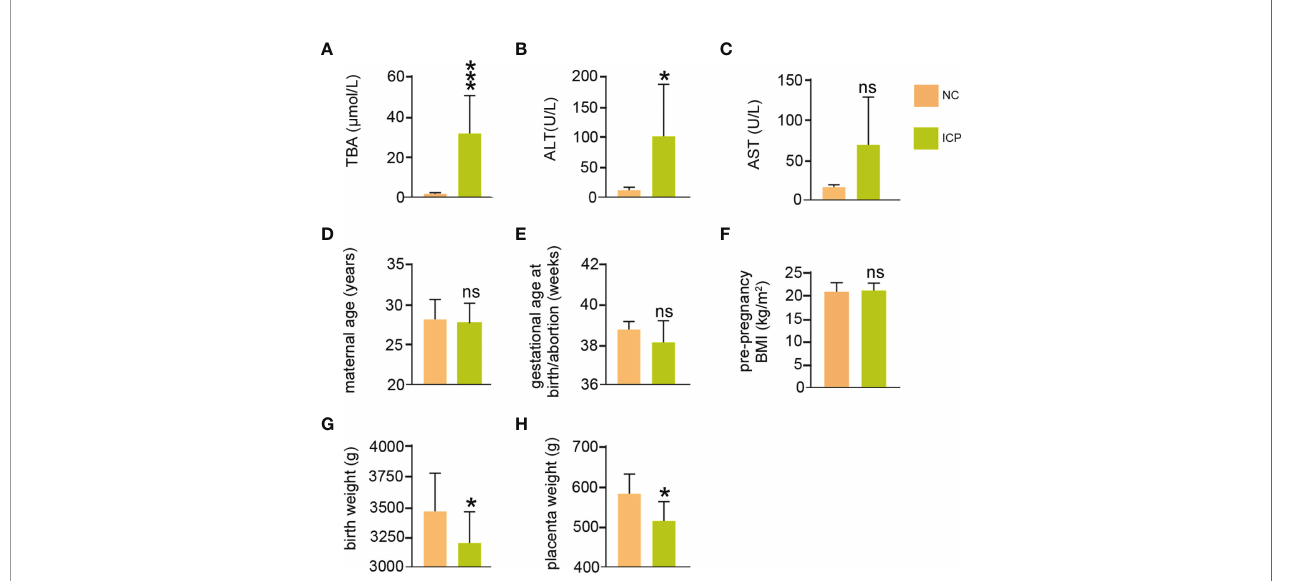
FIGURE 1 | The clinical data of pregnant women with ICP. (A) Maximum TBA levels during pregnancy of ICP group and normal group. (B, C) Maximum ALT and AST levels during pregnancy. (D) Maternal age at the time of termination of pregnancy. (E) Gestational age at birth. (F) Pre-pregnancy body mass index. (G) Fetal weight at birth. (H) Placenta weight at the time of termination of pregnancy. ns means not statistically signi fi cant * P < 0.05; vs. normal